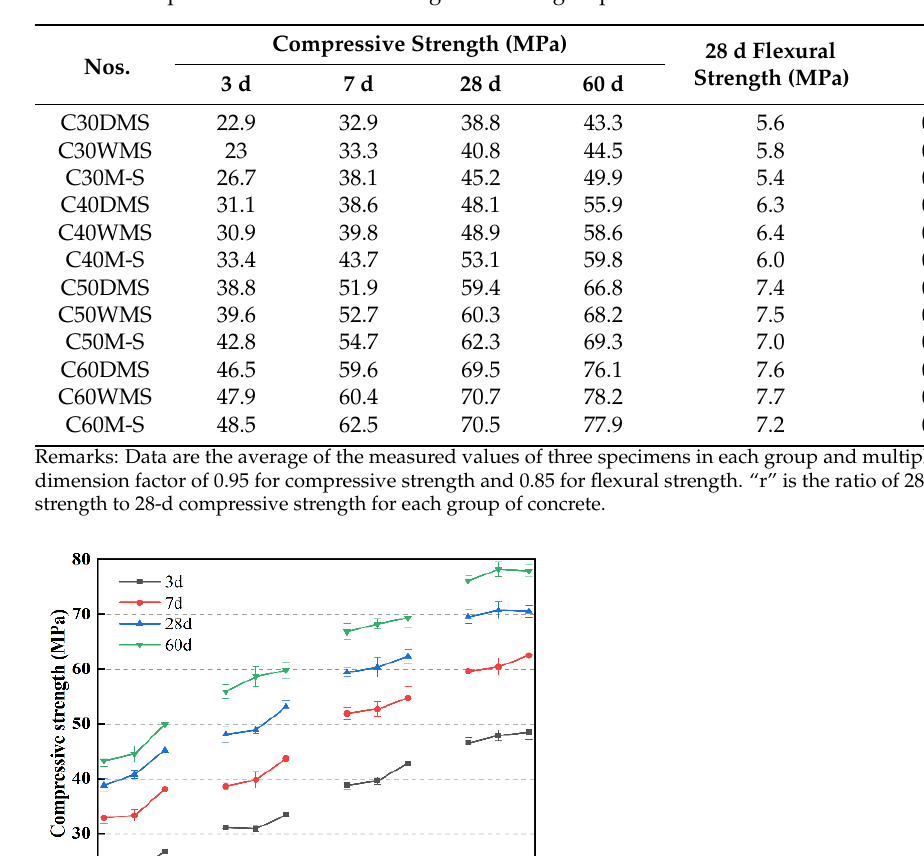
Table 6. Compressive and flexural strengths of each group.